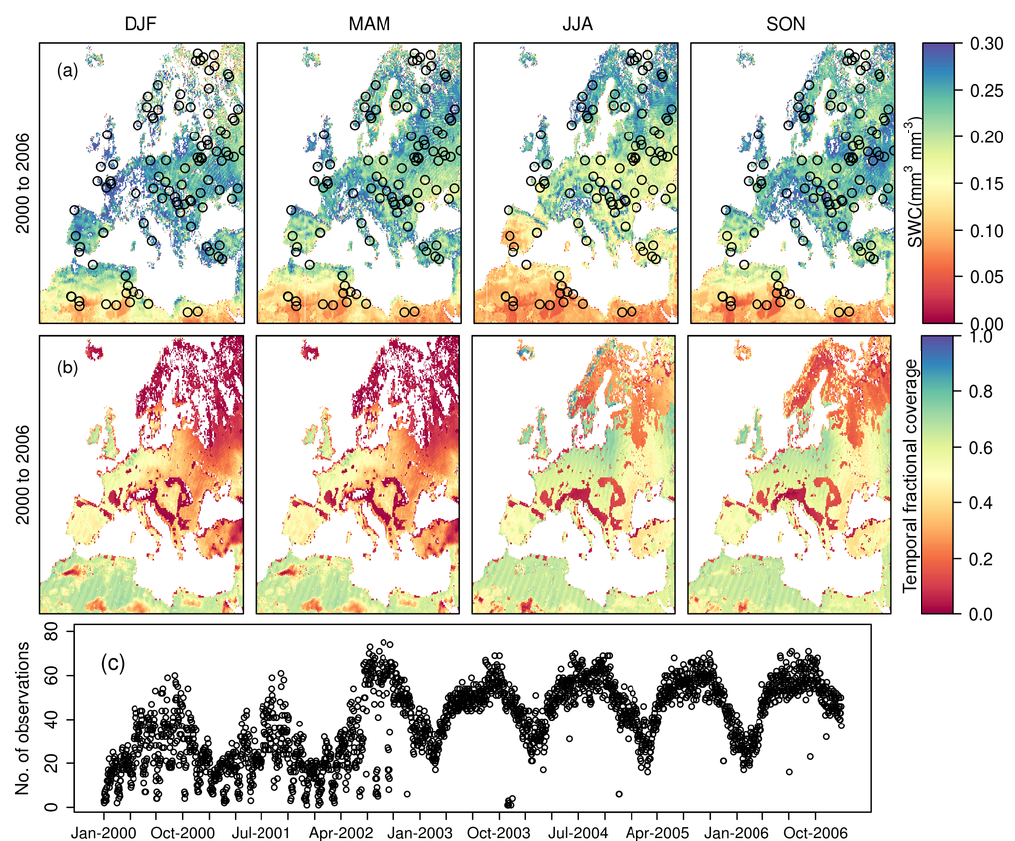
Figure 2. Satellite ESA CCI soil moisture data resampled to 3km resolution for the time period of 2000 to 2006 over EU-CORDEX. (a) Temporally averaged soil moisture content for different seasons, (b) fraction of days that soil moisture observations were reported during different seasons, and (c) number of selected observations with valid data for the respective day over the 2000–2006 period, used for assimilating soil moisture in the data assimilation experiment. Black circles in (a) indicate the location of grid cells selected for data